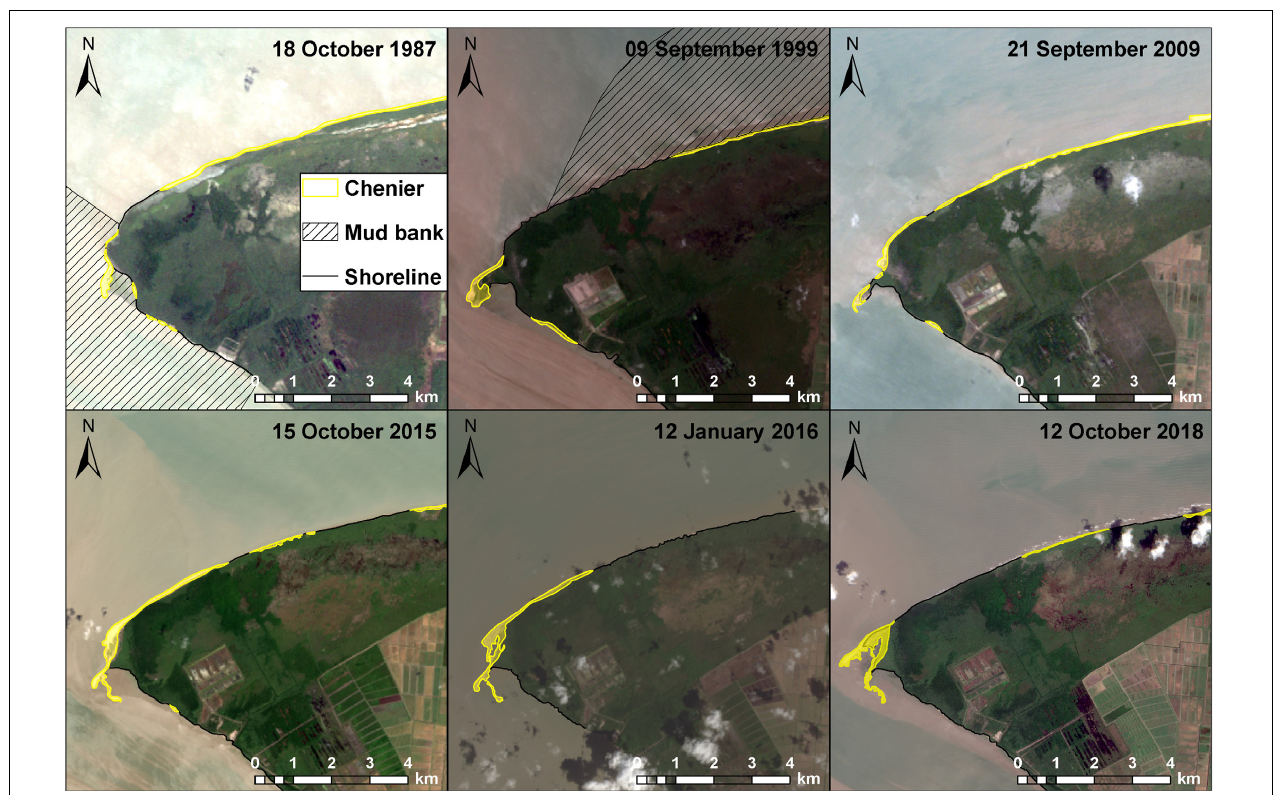
FIGURE 6 | Synthesis of analyzed changes in the Braamspunt chenier between October, 1987 and October, 2018. The latest development phase (October, 2018) of the chenier monitored in 2016, in the course of this study, has been marked by fragmentation and shortening of its downdrift sector near the distal tip of the mud cape impinging on the Suriname